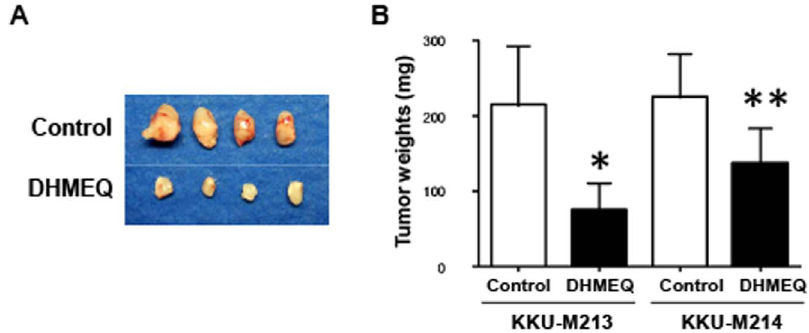
Figure 5. Inhibition of NF- k B action reduced growth of CCA in xenografted mice. Mice were subcutaneously injected with 4 6 10 6 CCA cells at both flank sides. A day after tumor injection, mice were intraperitoneally injected with PBS (control) or DHMEQ at 10 mg/kg body weight daily for 17 days. A) CCA tumor tissues obtained from control and DHMEQ-treated mice. B) Comparison of tumor weights obtained from control and DHMEQ-treated mice. * P , 0.05, ** P , 0.01; independent-sample t-test compared to the control